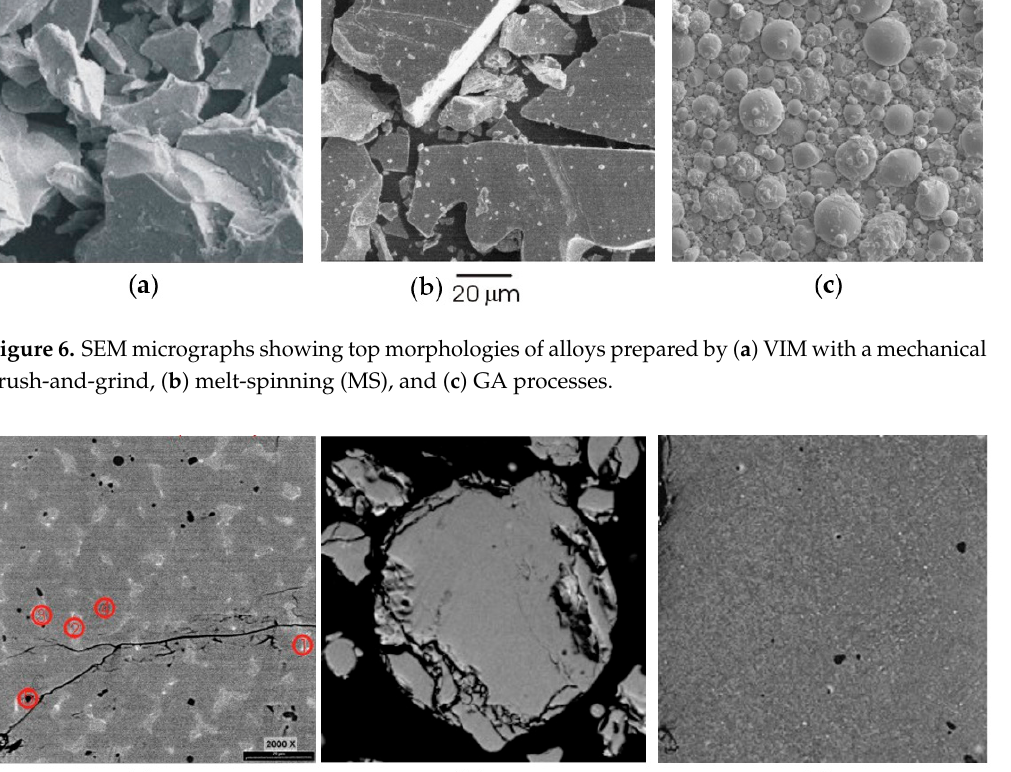
Figure 7. SEM cross-section micrographs from a C14-predominated alloy (Ti 12 Zr 21.5 V 10 Cr 8.5 Mn 13.6 Co 1.5 Ni 32.2 Sn 0.3 Al 0.4 ) prepared by ( a ) a conventional VIM, ( b ) GA, and ( c ) MS processes. Areas 1, 2, 3, 4, and 5 in (a) are C14, C15, TiNi, body-centered-cubic (bcc), and ZrO 2 phases, respectively, as determined by their compositions and crystal structures.